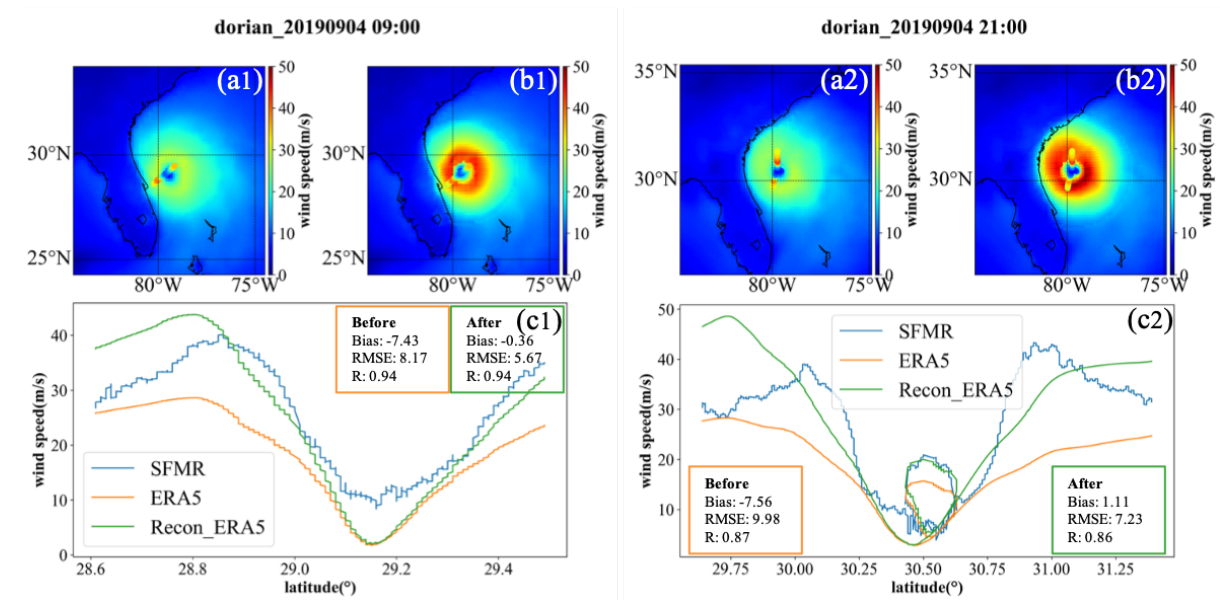
Figure 7. Comparison of wind field ( a1 – b2 ) and profile ( c1 , c2 ) before and after tropical cyclone reconstruction at Dorian in 2019.